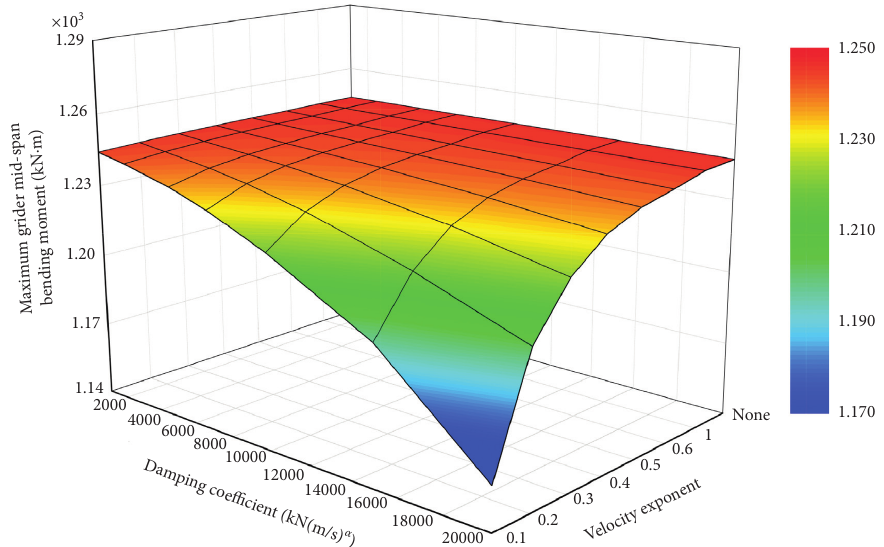
Figure 18: Maximum midspan girder bending moment M